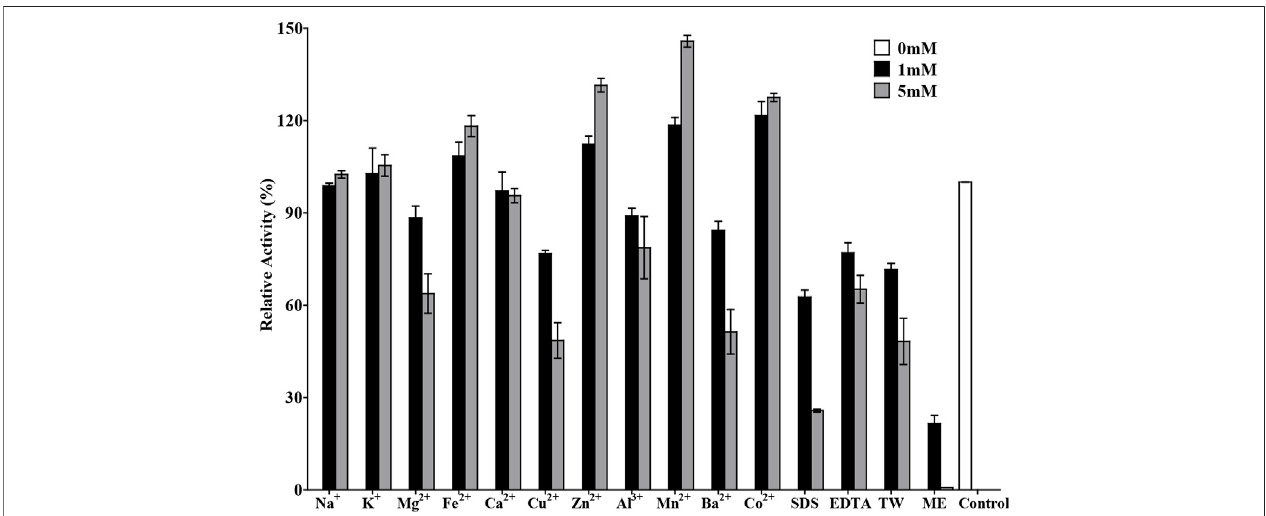
FIGURE 6 | Effects of chemicals and metal ions on the activity of TanA. The activity assayed without any chemical compound or metal ion was taken as control. SDS, sodium dodecyl sulfate; EDTA, ethylene diamine tetraacetic acid; TW, Tween 80; ME, mercaptoethanol.